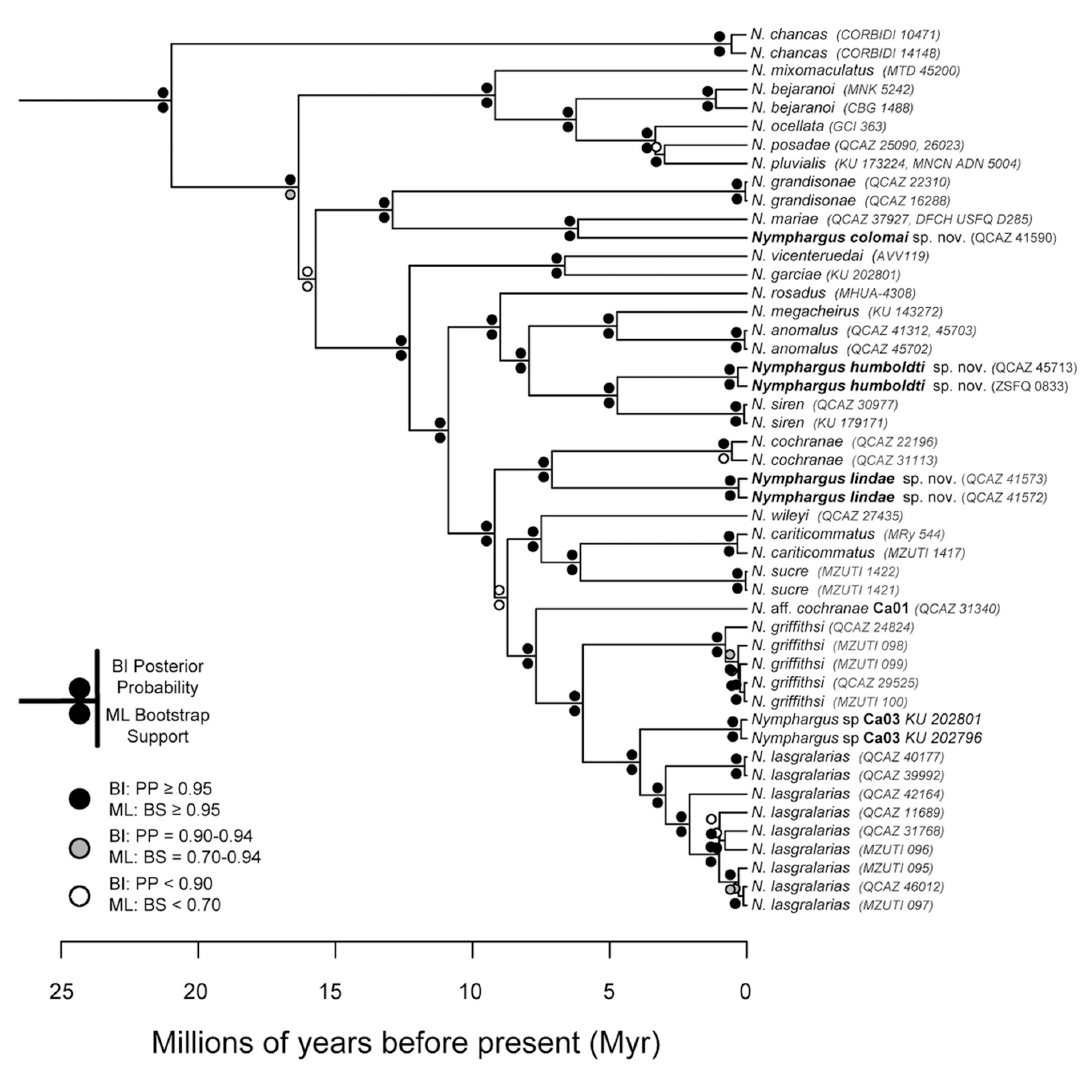
Figure 136. Evolutionary relationships of glassfrogs in the genus Nymphargus , inferred using maximum likelihood and Bayesian criteria.